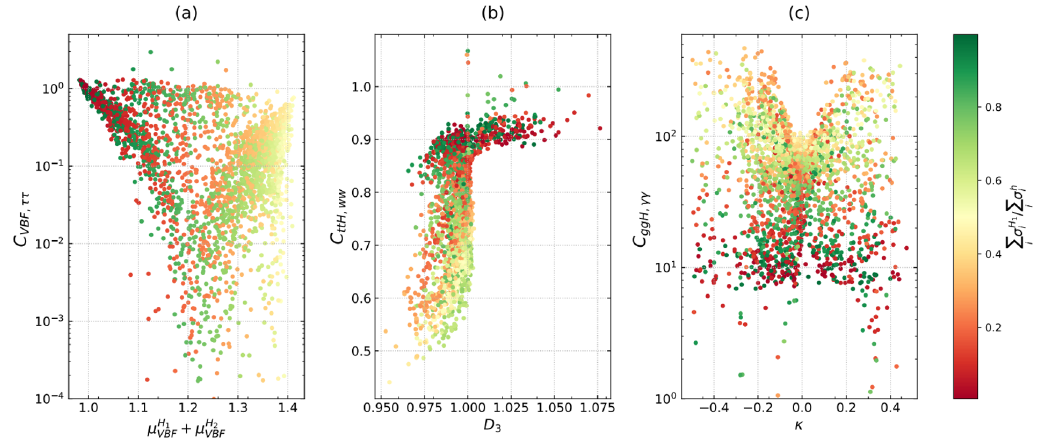
+ µ H 2 – C , D – V BF,ττ 3 V BF V BF